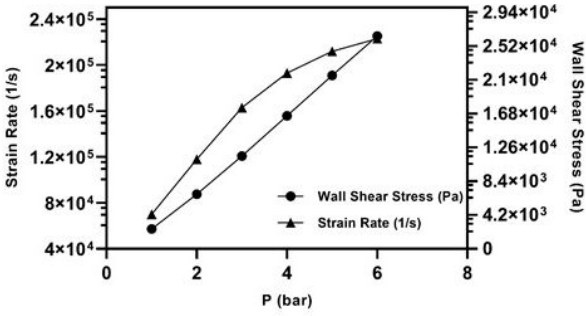
Figure 13: Graph representing the strain in liquid particles in cavitat- ing flow and also change in shear stress produced due to cavitation for inlet pressures